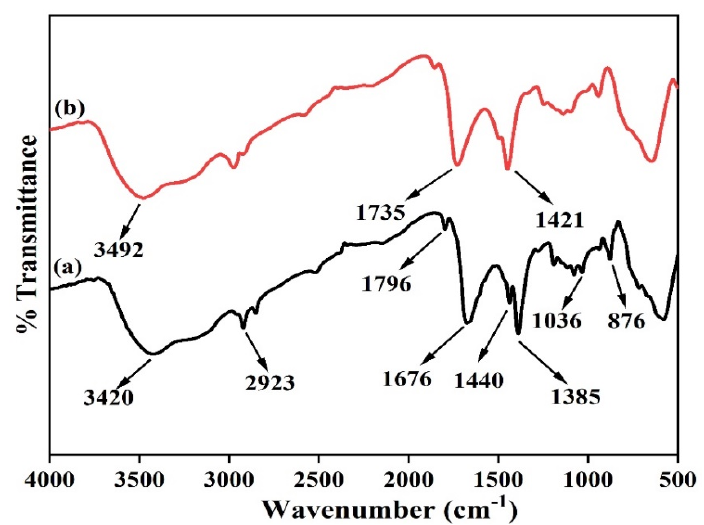
Figure 1. FTIR of spectra of xanthan gum-cl-poly(acrylamide-co-alginic acid) hydrogel ( a ) before adsorption and ( b ) after adsorption .